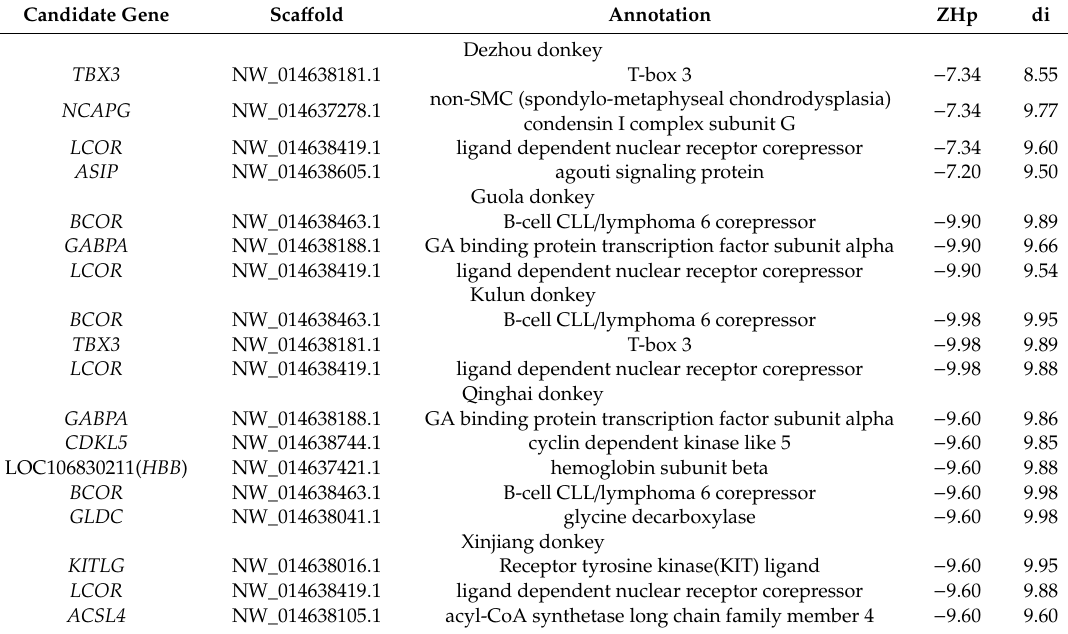
Table 3. Overlapping genes identified by both ZHp and di for di ff erent donkey